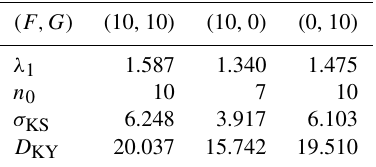
Table 1. Instabilities features of the VL20 model for the three forc- ing configurations; n = 36, and α = γ =